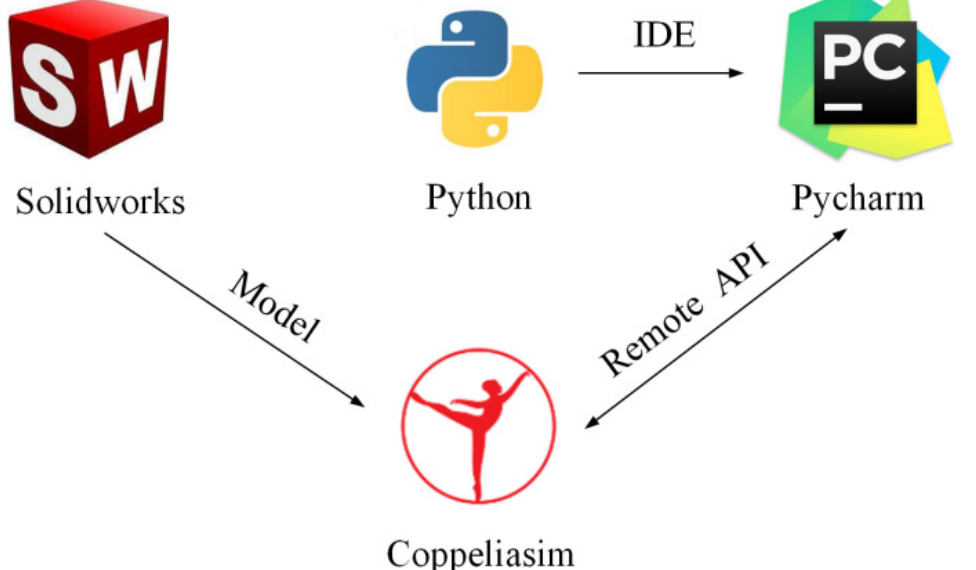
Figure 9. The construction of the joint simulation experiment platform.